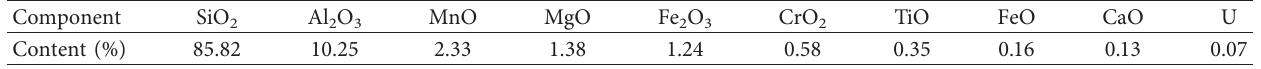
Table 1: Main chemical mineral components of the chosen uranium tailings sample.